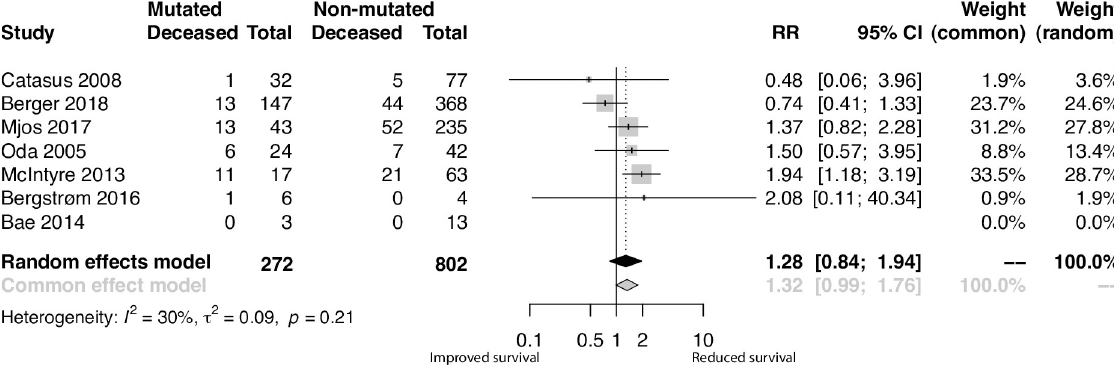
Fig 2. Meta-analysis results of the effect of PIK3CA mutations on EC patient survival. Forest plot visualizing relative risks (RR) of combined overall and disease-specific survival among studies included. Grey boxes represent relative risk of individual studies, with box size representing the inverse of the variance in individual studies and vertical black lines representing 95% confidence intervals. The diamonds represent the summarized effect of the PIK3CA mutation on survival for both the common effects and random effects models.